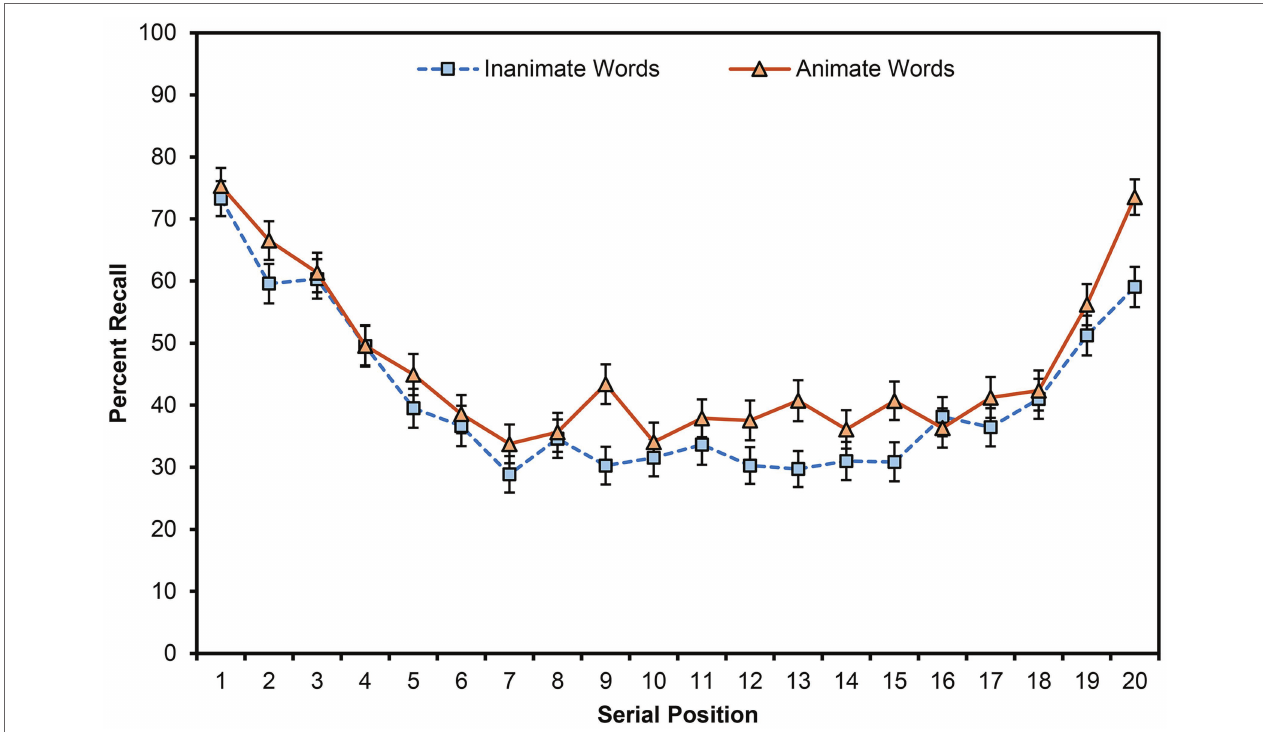
FIGURE 1 | The mean free recall (percent recalled) for animate and inanimate words that were presented at each serial position. Results are collapsed on list number. Error bars are one